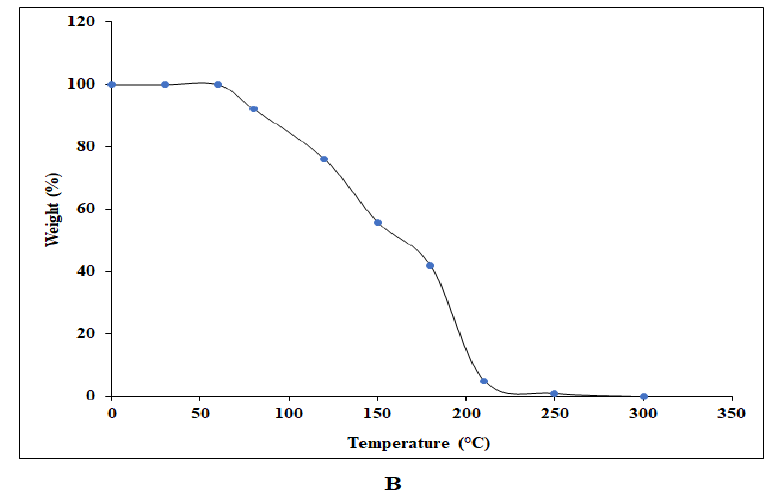
Pharmaceutics 2023 , 15 , x FOR PEER REVIEW Figure 3. Thermal analysis of lyophilized amikacin sulfate loaded dextran nanoparticles (LADNP). ( A ) Differential scanning calorimetry analysis of LADNP ( B ) Thermogravimetric analysis of LADNP.